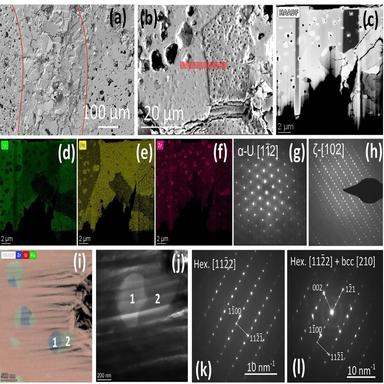
Radial zone 1 (between the two red lines in (a)) shows features of dual phases matrix; The higher magnification SEM image shows both phases containing a large number of fine pores and precipitates (b); STEM dark field (DF) image shows some of the pores are surrounded by nano precipitates (c); STEM-EDS shows the two matrix phases have different ratios of U/Pu: The left grain is rich in U while the right in Pu. Nano precipitates are rich in Pu and Zr compared with the matrix (d-f); SAED pattern indexing shows